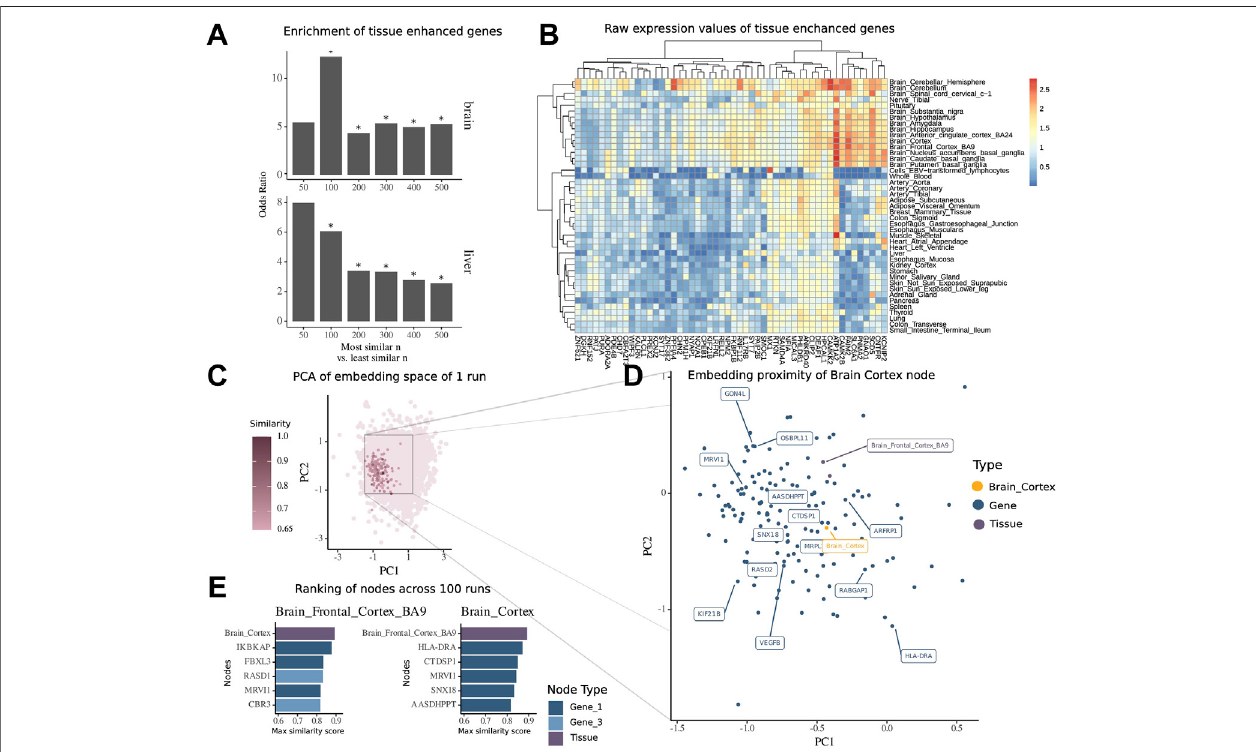
FIGURE 3 | Embedding of multimodal network identi fi es tissue-associated genes. (A) Enrichment of tissue-enhanced genes within the top n most similar nodes compared to bottom n least similar nodes by mean similarity score across 100 runs of embedding in expression in the brain and liver. (B) Median expression per tissue withintheGTExdatasetof50genesfoundtobeenrichedinexpressioninthebrainamongthetop500mostsimilarnodes. (C) Embeddingofallnodesofthemultimodal network of a representative run, highlighted are nodes with high similarity score of tissue node brain cortex. (D) Zoomed-in view of embedding space around brain cortex with 15 topmost similar nodes highlighted by labels. (E) Ranking of most similar nodes for brain cortex and brain frontal cortal BA9 across all 100 runs of embedding, with 1-hop neighbor genes in dark blue and 3-hop neighbor genes in light blue.